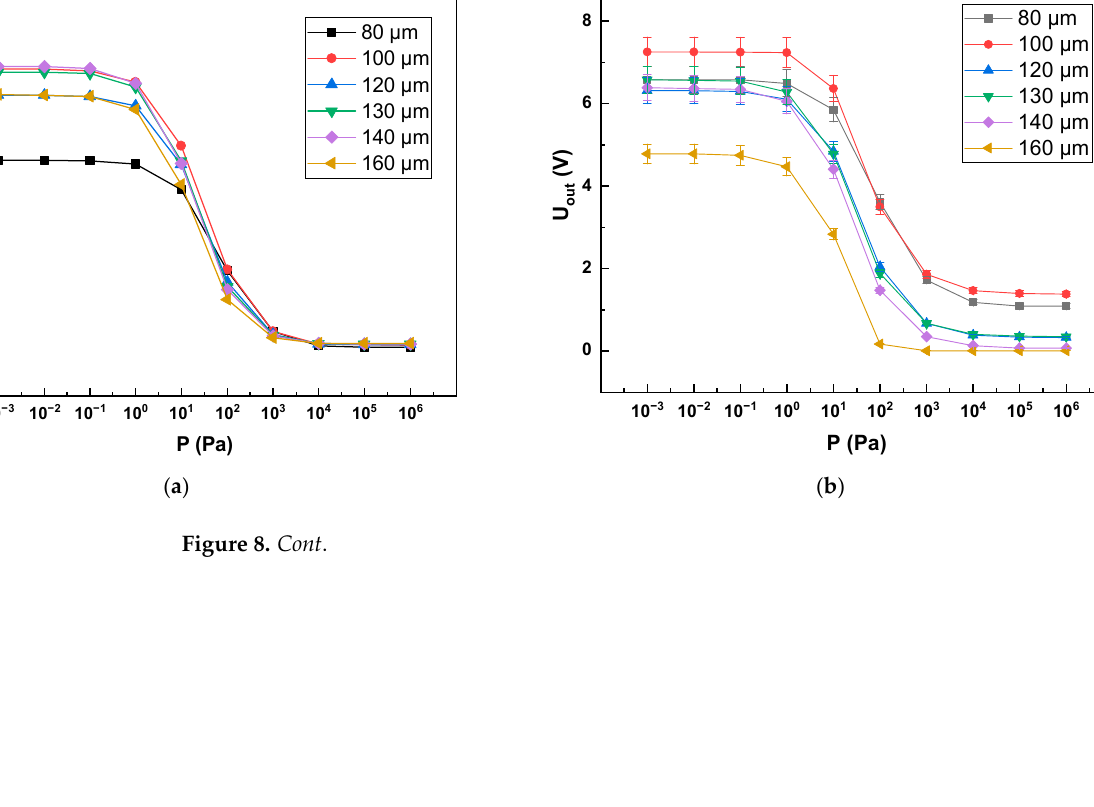
Figure 8. Range and sensitivity of Pirani gauge in different heat sensitive areas. ( a ) Variation trend of VOx temperature with pressure in Pirani equilibrium state under different thermal sensitive ar- eas; ( b ) Variation trend of output voltage with pressure in Pirani equilibrium state under different thermal sensitive areas; ( c ) Sensitivity of Pirani gauge at different pressure intervals for different thermal sensitive areas; ( d ) The influence of the area of thermal sensitive zone on the sensitivity of Pirani gauge in different pressure ranges. 4.4. The Depth of the Cavity As shown in Figure 9, after simulation, it was found that the air gap had no obvious influence on the Pirani gauge performance. This is because we added two heat fluxes to replace the conduction of gas molecules in the simulation, as shown in formula (9). We substituted Equation (8) into Equation (9), after simplification: 𝑞 = 𝜆(𝑃 (cid:2868) ) 𝑑 + 5𝑙 (𝑇 − 𝑇 (cid:2868) ), (11) where l is the mean free path of a gas molecule. When pressure P < 1000 Pa , d ≪ 5 l , the effect of d on 𝑞 can be ignored; when the pressure P > 1000 Pa, d begins to affect 𝑞 , and as the pressure continues to increase, the influence of d becomes more obvious.